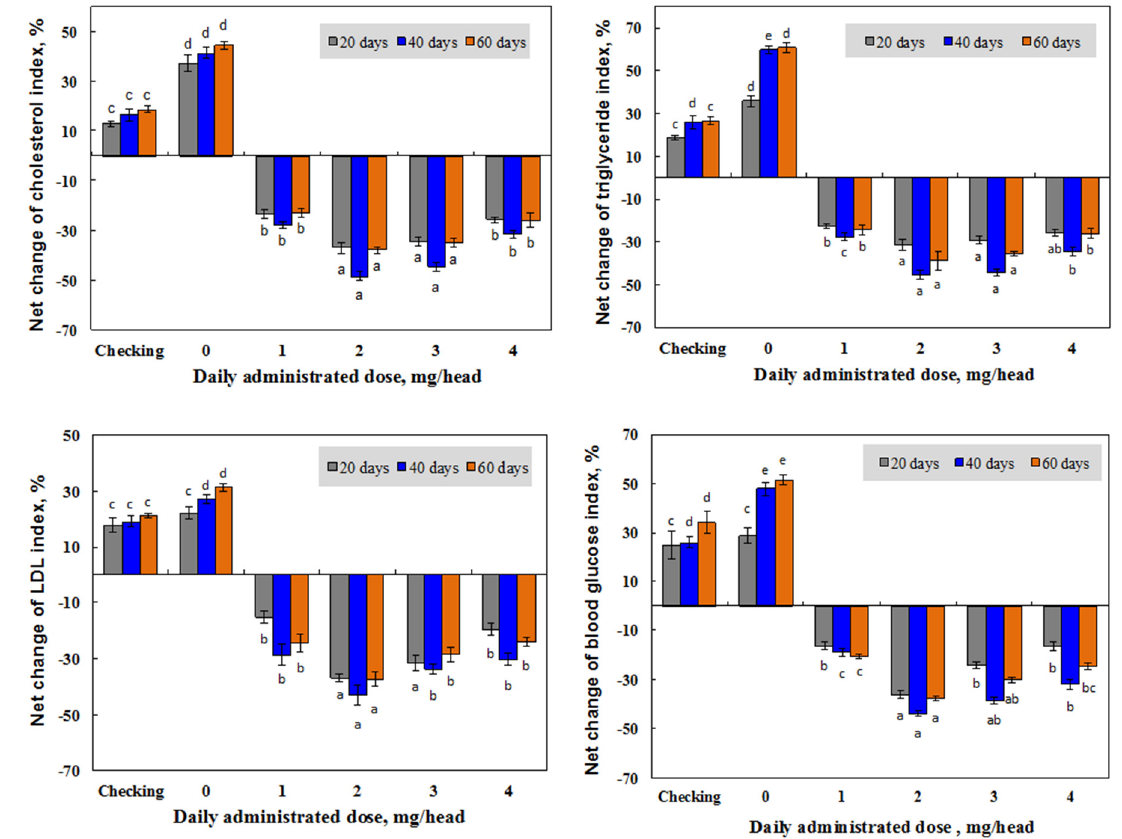
Figure 7. Net change of blood lipid and glucose levels in mice after 20 and 40 days administration of β -glucan with a molecular weight of about 25kDa at different doses, and after stopping administrating for following 20 days (60 days).